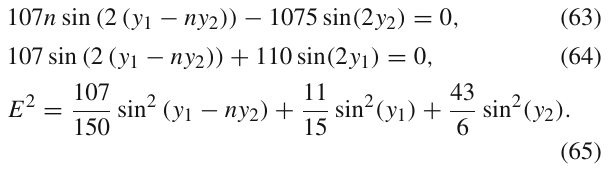
Fig. 3 Contour domains of restrictions (63) (solid red line) and (64) (dashed blue line). At the points where the two lines coincides are found the equilibrium points of the system